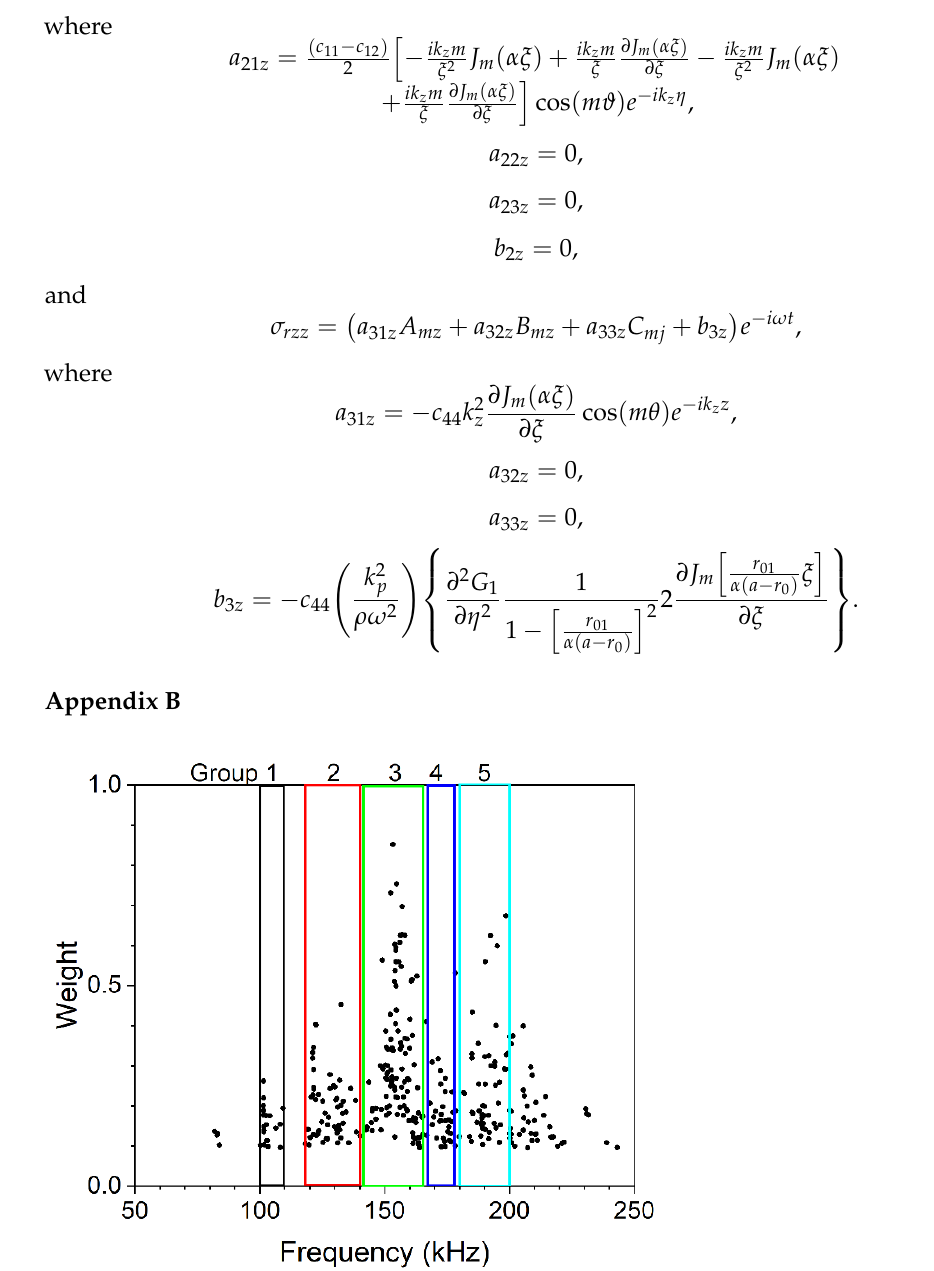
Figure A1. Distribution of resolved frequency components and the 5 groups selected using a 10 kHz wide window. The experimental data are obtained from a tensile test using AISI 316 austenitic stainless steel (KS D 3698 standard). Table A1. Resolved frequency components ( ν ’s) and their relative weights of 316 stainless steel.